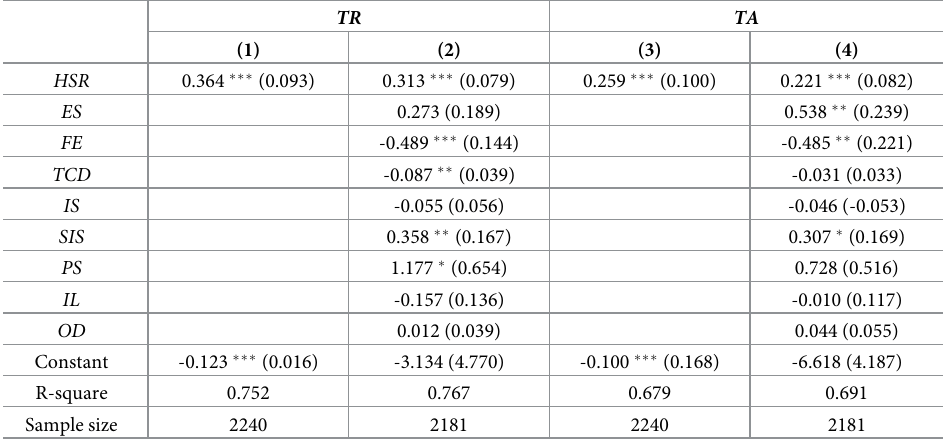
Table 2. Benchmark regression